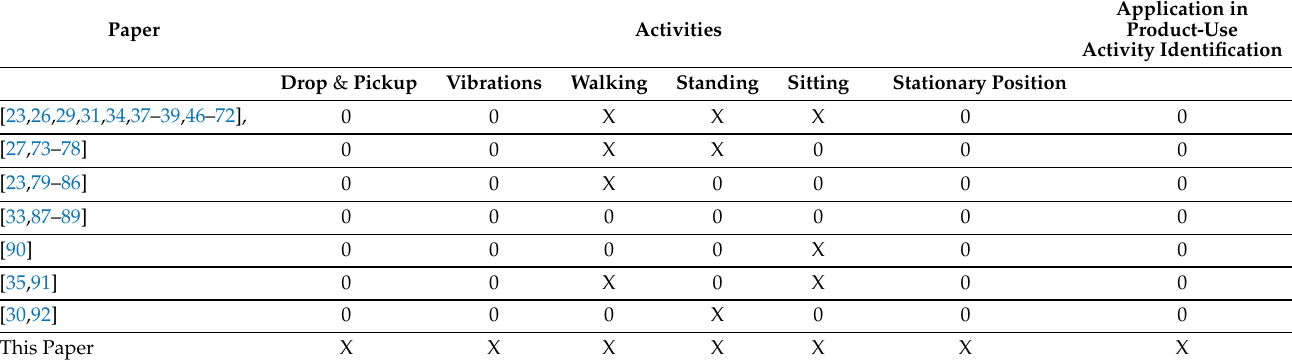
Table 1. Summary of activity recognition on vibration, drop and pickup, standing, sitting, walking, and stationary position. Paper